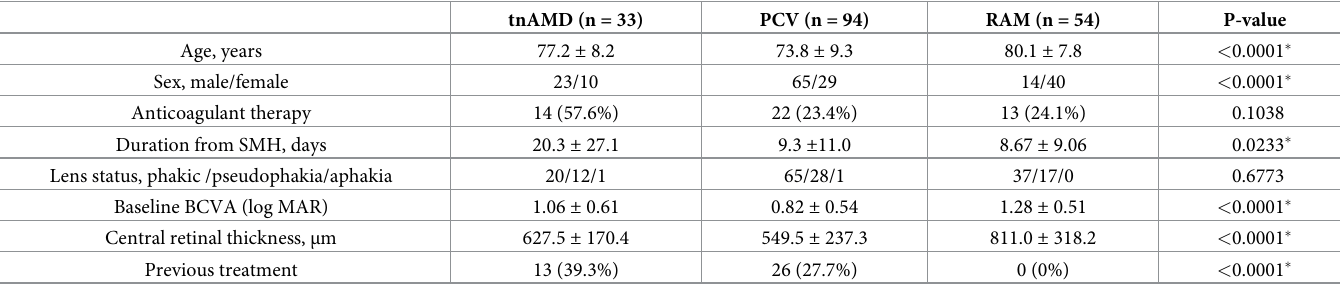
Table 1. Clinical characteristics of study